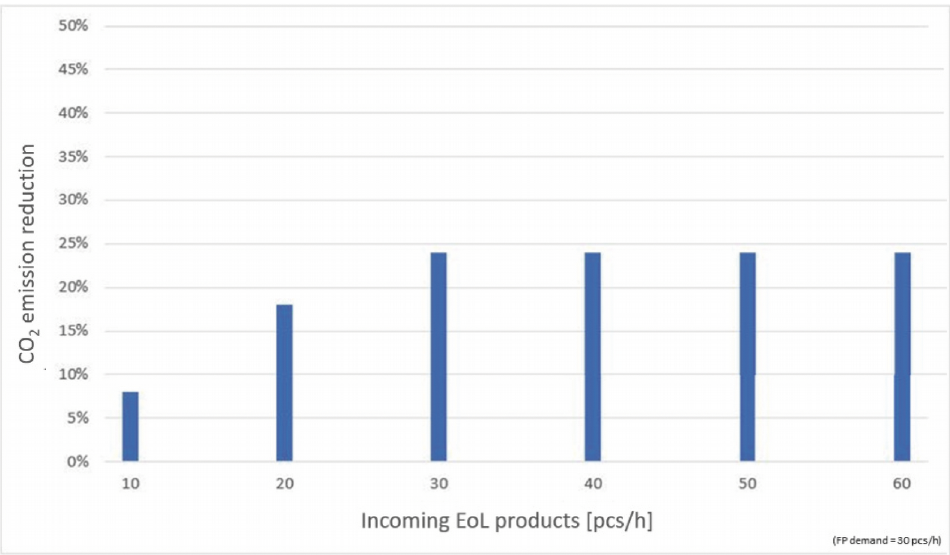
Figure 9. CO emission reduction by varying the number of EoL 2